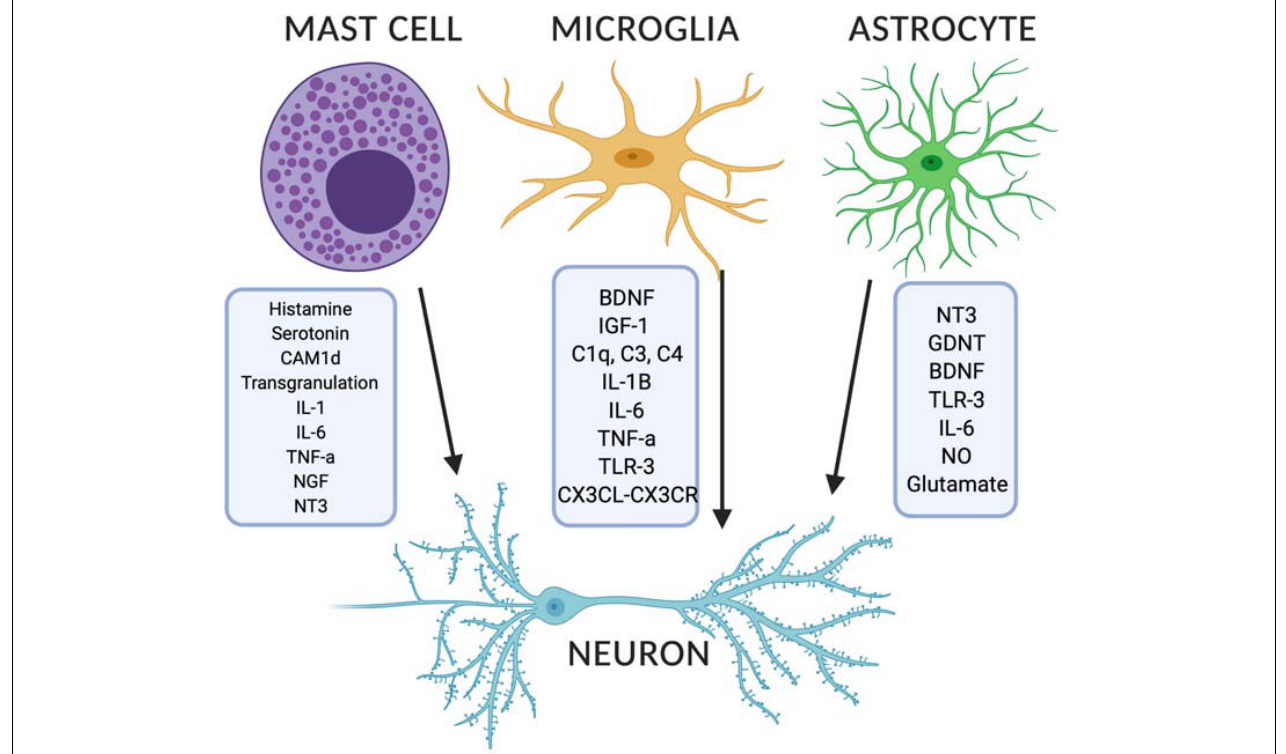
FIGURE 3 | Released modulators from mast cells, microglia and astrocytes can impact on developing neurons in the brain. Image created with BioRender.com. BDNF, brain derived neurotrophic factor; CX3CL, CX3C chemokine ligand 1; CX3CL, CX3C chemokine receptor; GDNF, glial derived neurotrophic factor; IGF-1, insulin-like growth factor 1; IL, interleukin; NGF, nerve growth factor; NO, nitric oxide; NT3, neurotensin 3; TLR, toll like receptor; TNF- α , tumor necrosis factor